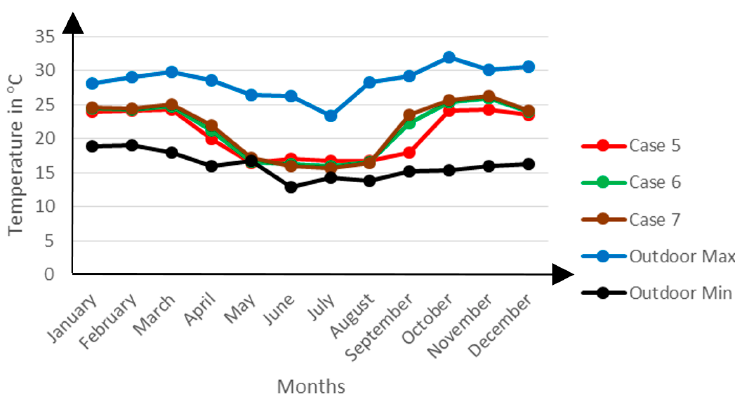
Figure 11. Comparison of indoor and outdoor temperatures for Cases 5, 6 and 7.